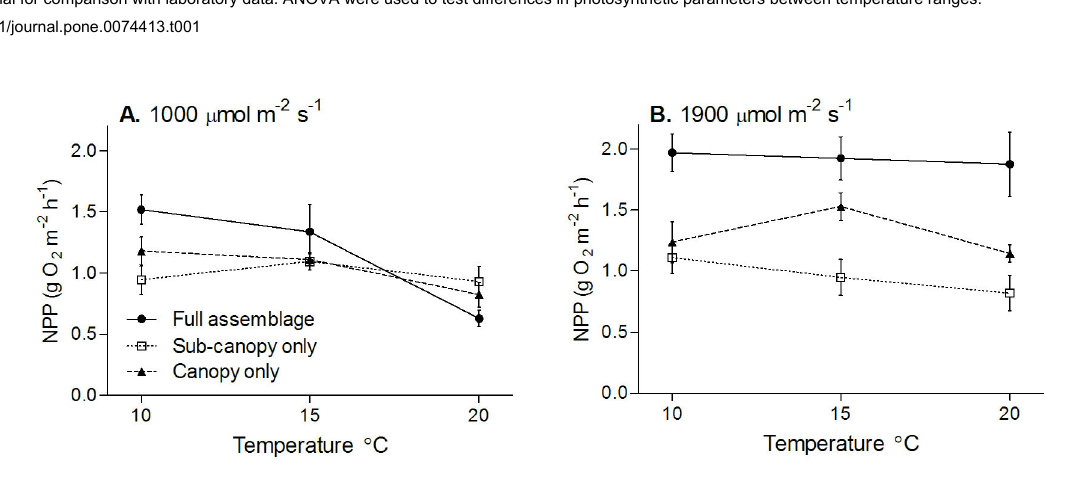
algal material for comparison with laboratory data. ANOVA were used to test differences in photosynthetic parameters between temperature ranges.